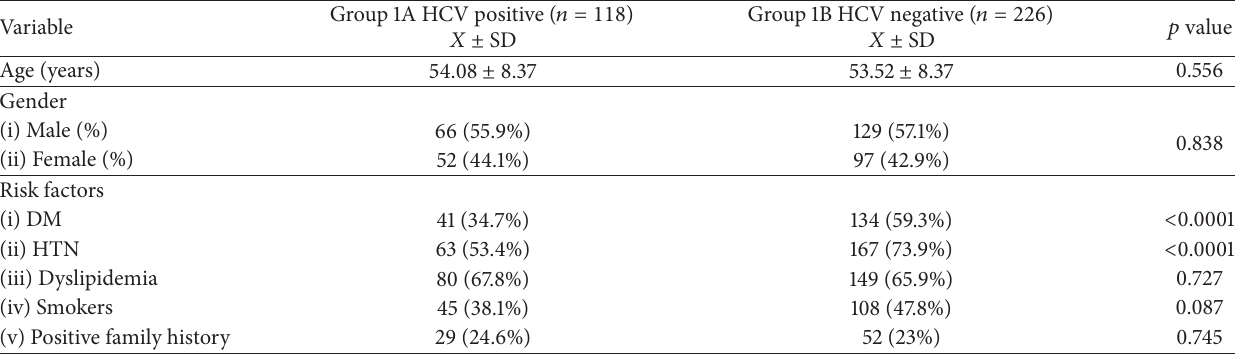
Table 2: Demographic and clinical characteristics of the HCV-positive and HCV-negative groups.